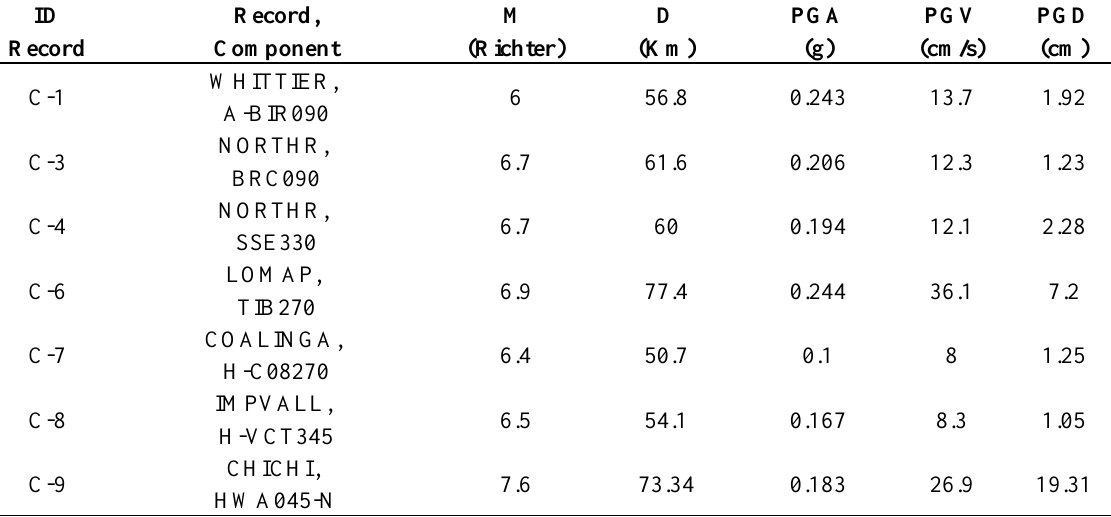
Table 6. Set of ground motion records in soil type